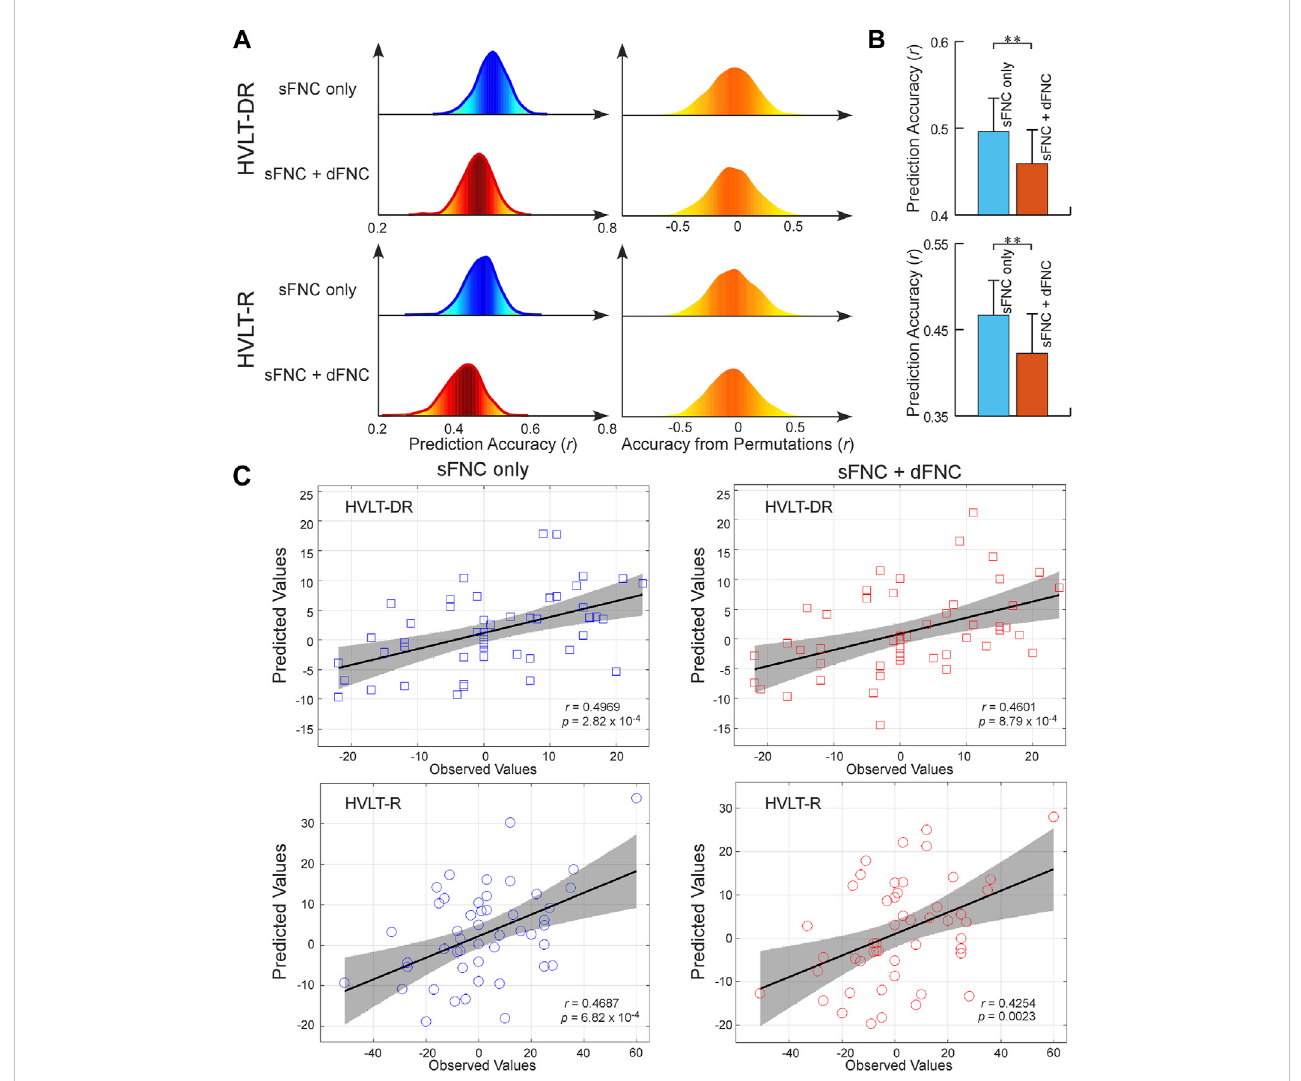
FIGURE 3 FNC-basedpredictionresultsforcognitivechangesinducedbyECT. (A) Distributionofpredictionaccuraciesacross1,000repetitionsofcross-validation and distribution of accuracies based on permutation testing across 1,000 iterations. (B) Statistical analysis between prediction accuracies based on sFNC features only and based on combined features (sFNC+dFNC). (C) Scatter plot shows prediction of changes in HVLT scores. Considering that the prediction framework was repeated 1,000 times, we only show results from the iteration with the median prediction